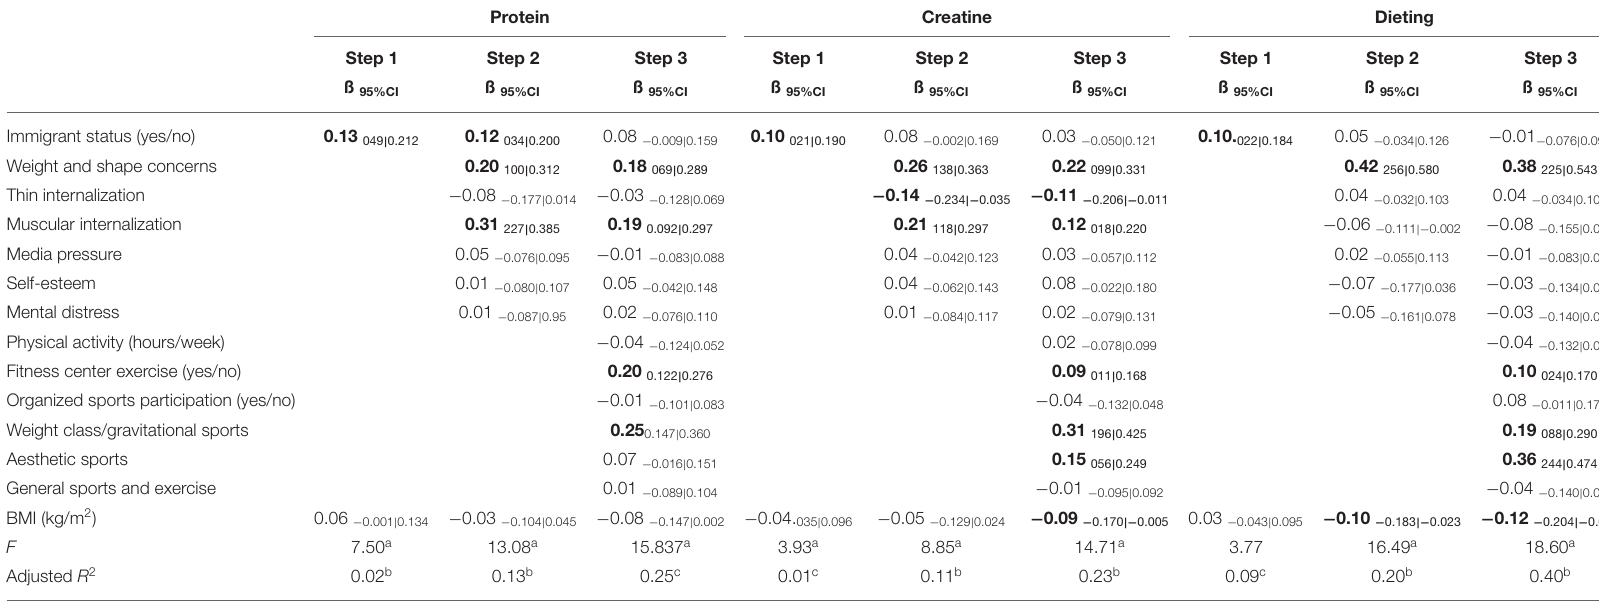
TABLE 3 | Bootstrapped hierarchical linear regression analysis of variables explaining the variance in boys’ ( n = 629) weekly (0–7) use of protein, creatine, and dieting supplements, respectively. Protein Creatine